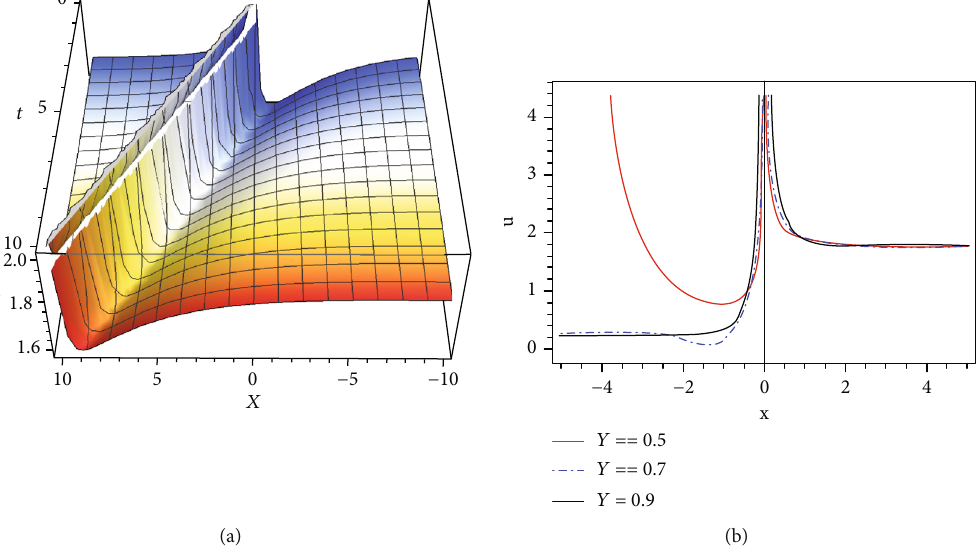
= 1 , T = 2 , V = 1 , c = 3 , a = 1 , b = 1 , and γ = 0 : 5,0 : 7,0 : 9 for the solution j u 1 ð x , t Þ with distinct values of γ . 15